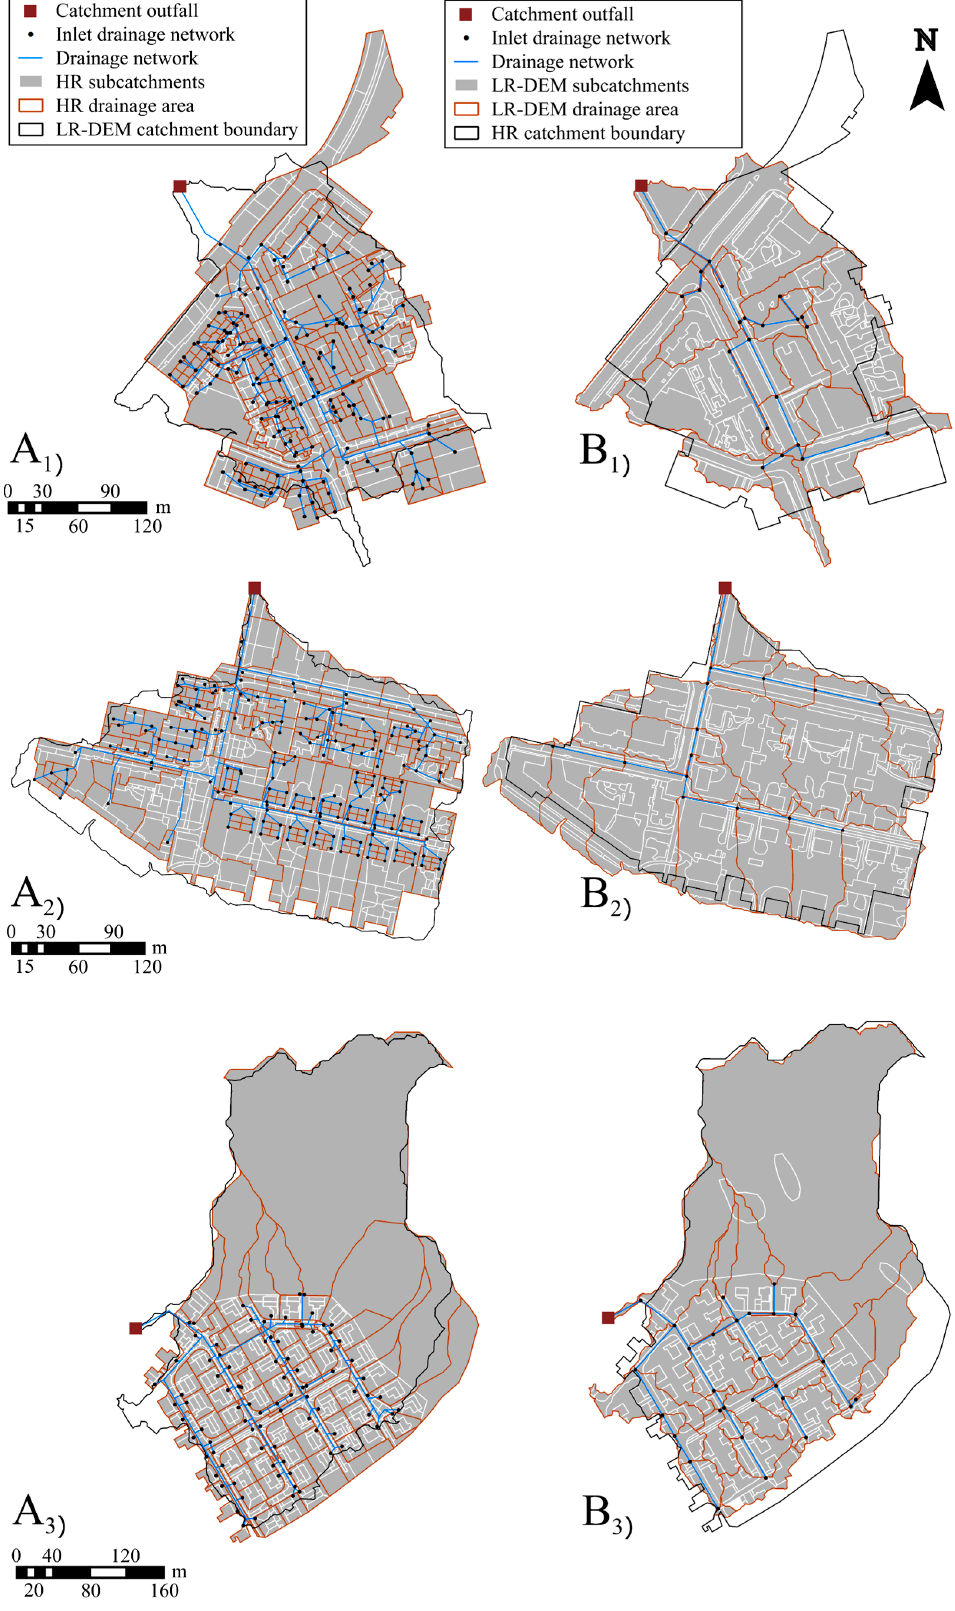
Figure 2. ( A 1 , A 2 , A 3 ) Surface discretization for the HR model and ( B 1 , B 2 , B 3 ) the boundaries based on DEM delineation and the surface discretization for the LR ‐ DEM model for Catchments 1, 2, and 3.